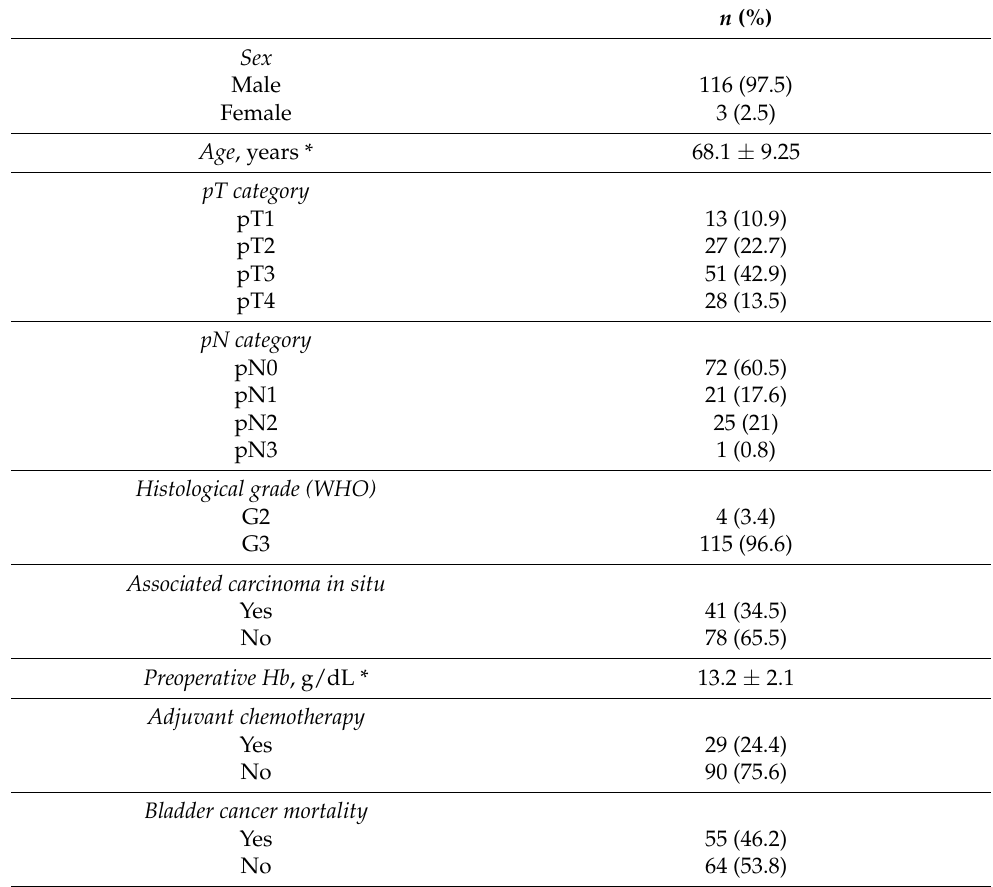
Table 1. Characteristics of the series ( n = 119); * Mean ±